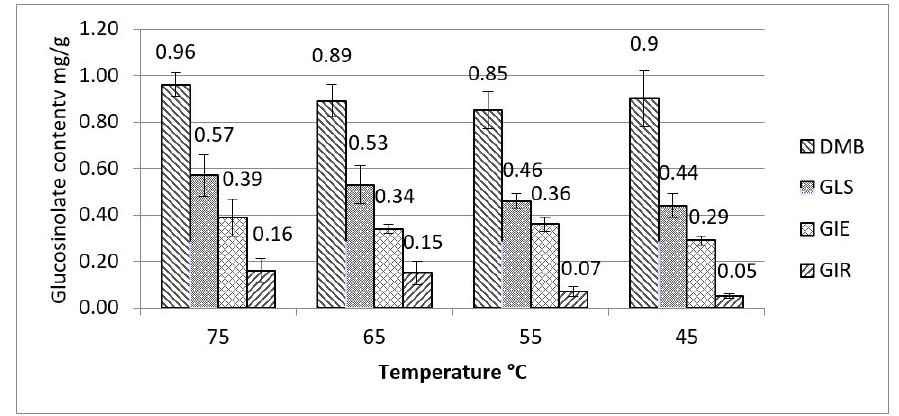
Figure 3. Glucosinolates composition (mg/g) of Eruca sativa extract obtained by SCO 2 at 75 ◦ C, 65 ◦ C and 55 ◦ C, keeping constant the other parameters; differences were not statistically significants ( p > 0.05). Compounds are abbreviated as follow. Glucoerucin: GlE; Glucorafanin: GlR;